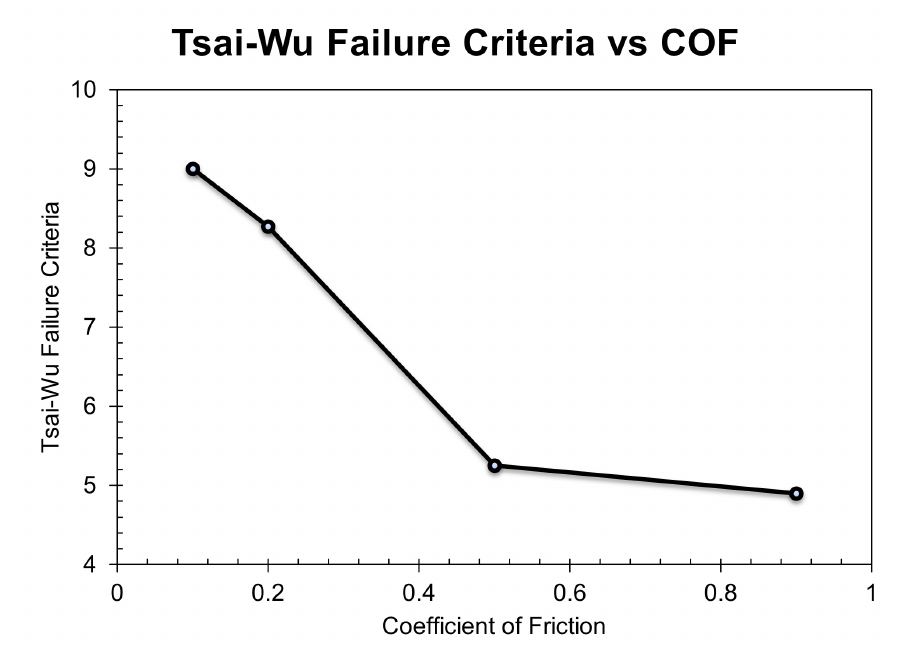
Figure 14. Variation of Tsai-Wu failure criterion factor with co-efficient of friction.